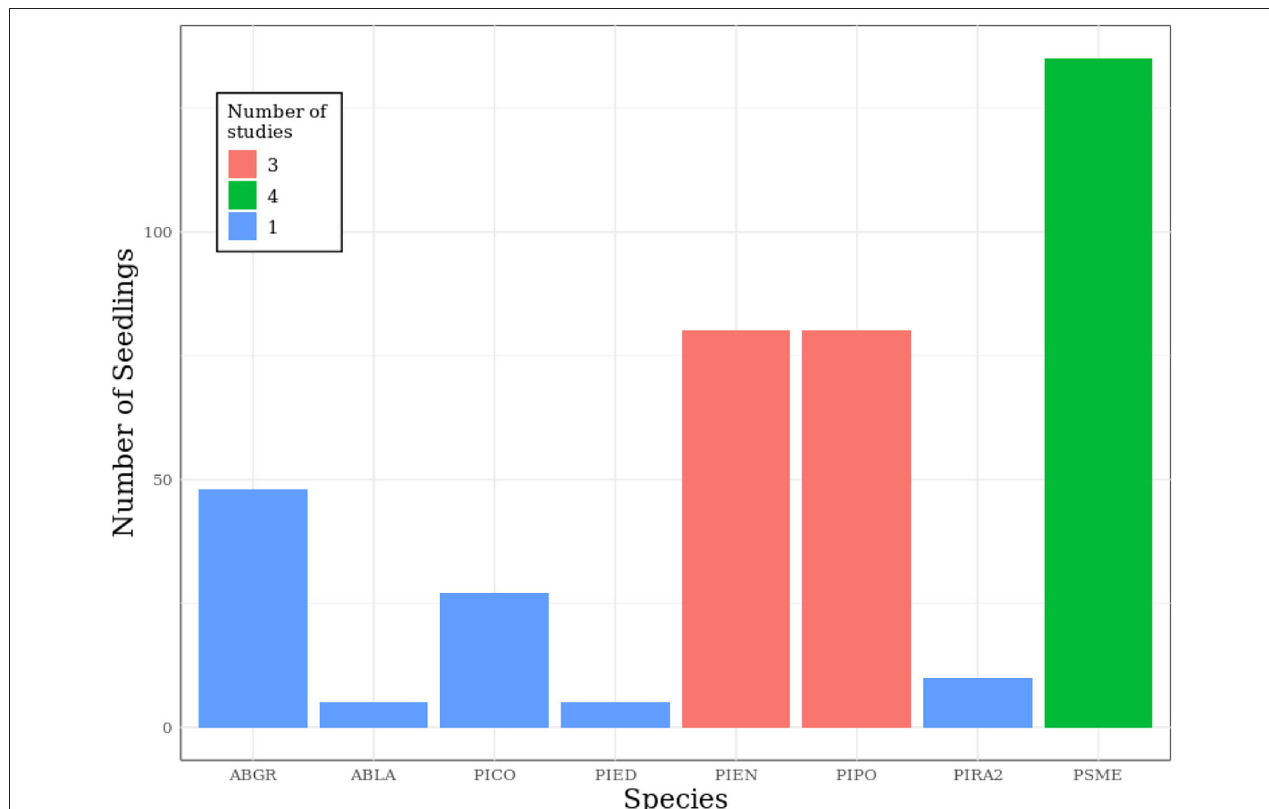
FIGURE 1 | Summary of seedling populations used in each of the studies from the literature search. Most experimental designs included four types of seedlings, with the exception of Baker 1929 and Silen 1960. Species represented in the dataset include Abies grandis (ABGR), Abies lasiocarpa (ABLA), Pinus contorta (PICO), Pinus edulis (PIED), Picea engelmannii (PIEN), Pinus ponderosa (PIPO), Pinus radiata (PIRA2), and Pseudotsuga menziesii